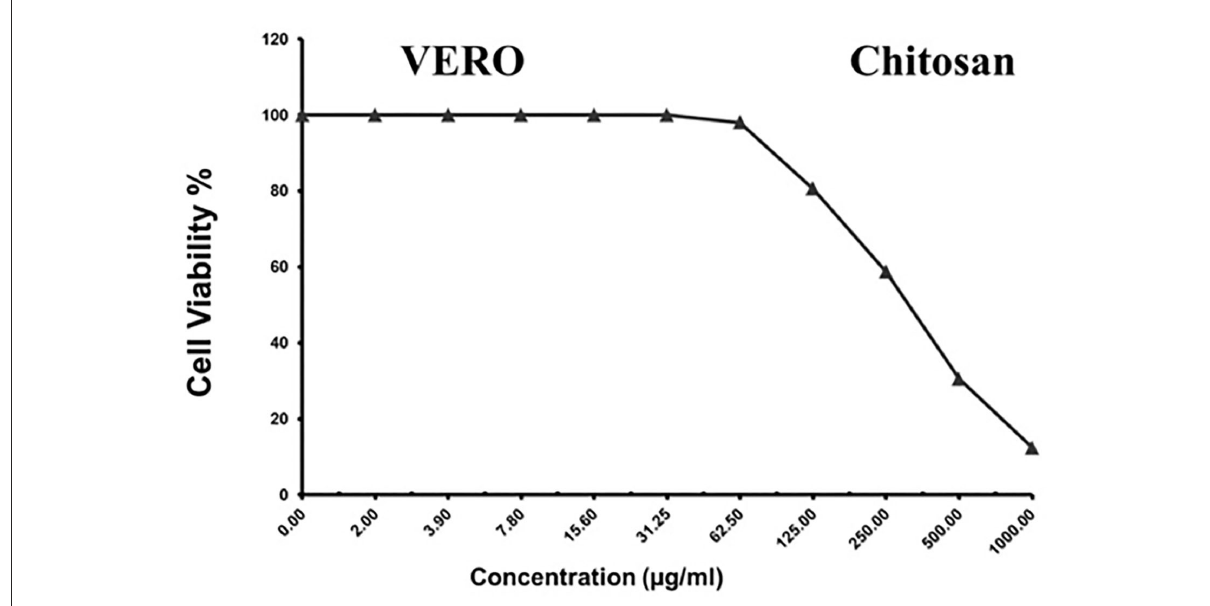
FIGURE3 Cytotoxic activity of chitosan in mammalian cells derived from African Green Monkey kidney (Vero) cells at a 50% cell cytotoxic concentration.